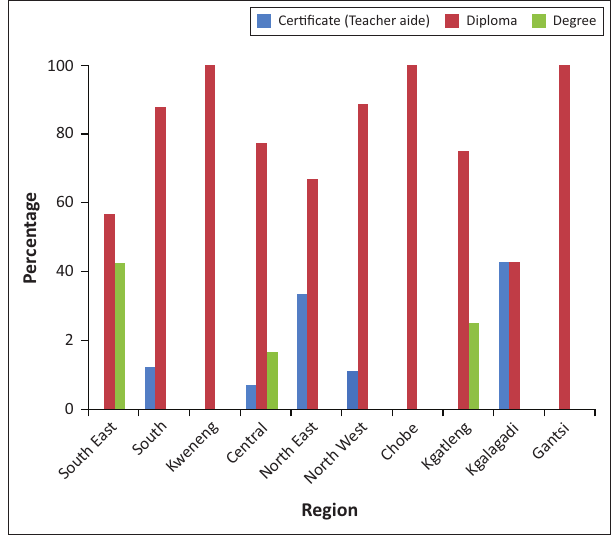
FIGURE 2: Reception class teachers’ qualifications by